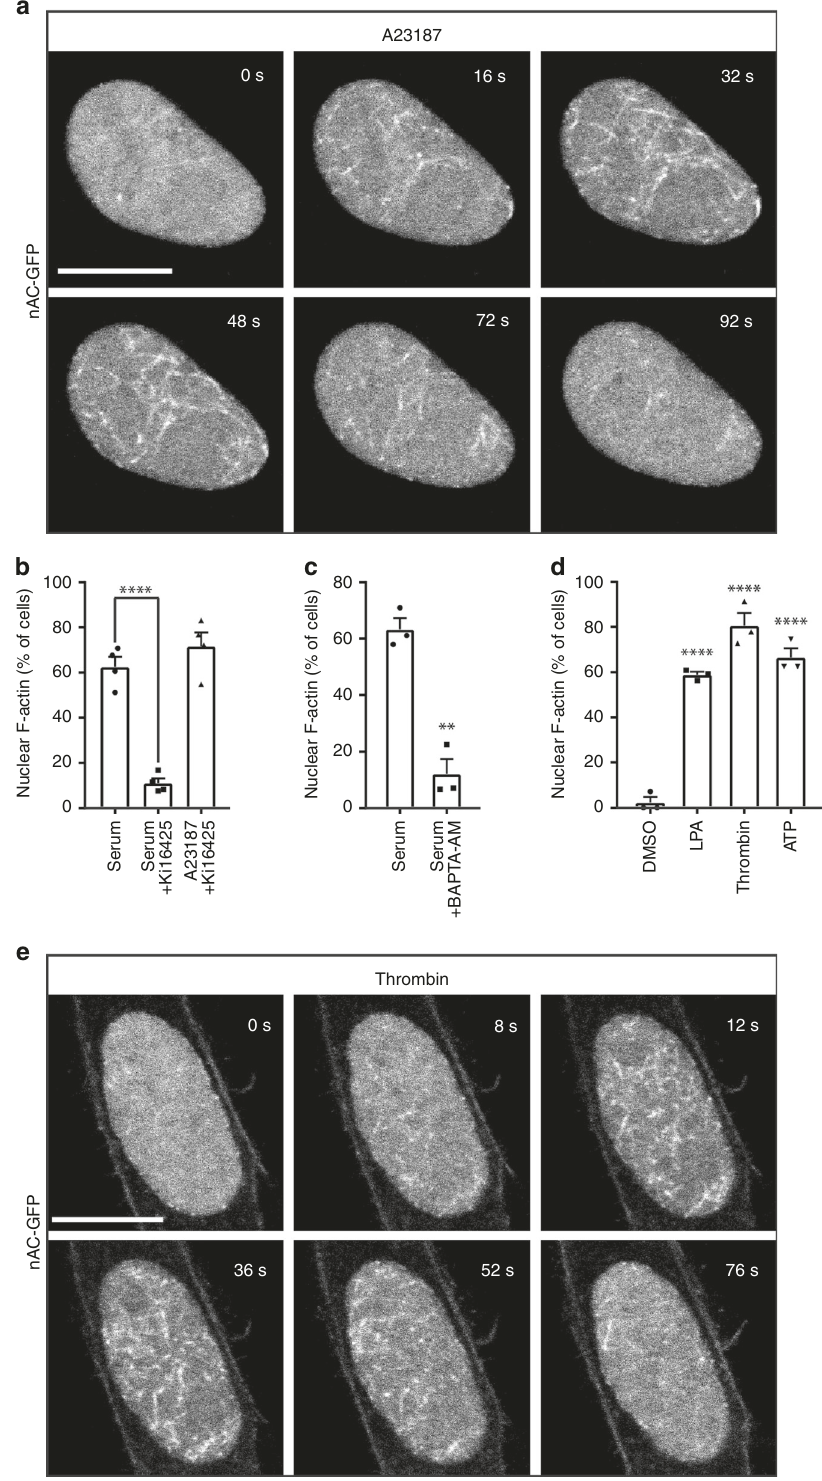
Fig. 1 Calcium transients induce nuclear F-actin assembly. a Representative images of NIH3T3 cells stably expressing nAC-GFP after A23187 stimulation. In total, 73.6%±7.6% (s.e.m.) cells exhibited NAA. Each experiment included three samples in parallel, and about 30 cells were recorded and counted each time. Experiments were repeated three times ( n = 3). Scale bar: 10 μ m. b NIH3T3 cells stably expressing nAC-GFP were stimulated with 20% serum or A23187 (750nM) after pre-treatment with or without LPA receptor inhibitor Ki16425 (20 μ M) at the confocal microscope. n = 4 independent experiments. One-way ANOVA test, **** p ≤ 0.0001. c NIH3T3 cells stably expressing nAC-GFP were stimulated with 20% serum after pre-treatment with or without BAPTA-AM (10 μ M). n = 3 independent experiments. Two-sided Student's t test, ** p ≤ 0.01. d NIH3T3 cells stably expressing nAC-GFP were stimulated with LPA (20 μ M), thrombin (0.2U/mL), or ATP (10 μ M). n = 3 independent experiments. One-way ANOVA test, **** p ≤ 0.0001. Error bars: + s.e.m. e Representative images of NIH3T3 cells stably expressing nAC-GFP after thrombin stimulation. Experiments were performed three times, and about 30 cells were recorded each time. Eighty percent of the cells were positive for NAA as shown in panel d . Scale bar: 10 μ m. Source data are provided as a Source Data fi